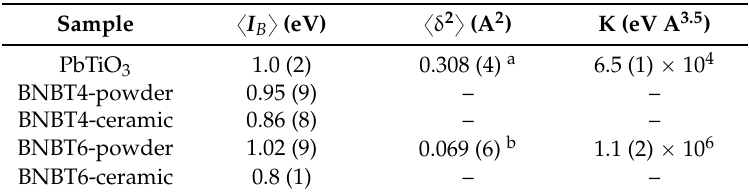
Table 3. XANES results for BNBT100 x